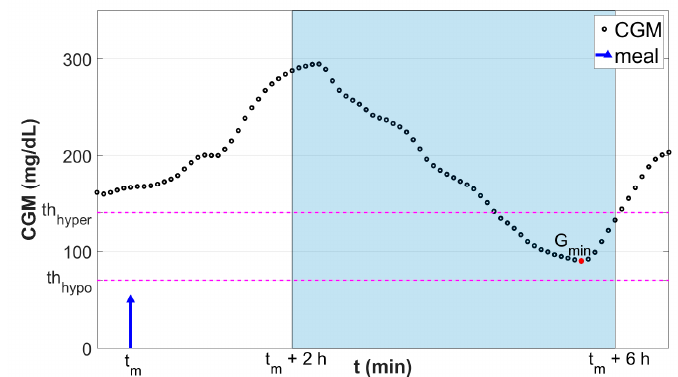
Figure 1. Graphical representation of the classification scheme. Black dots are the continuous glucose monitoring (CGM) samples. Blue stem indicates the meal event. Red dot is the minimum glucose level G min reached in the fixed postprandial window (t m + 2 h, t m + 6 h; highlighted in light blue). Horizontal magenta lines denote the thresholds used to discretize G min into the classification target Y .